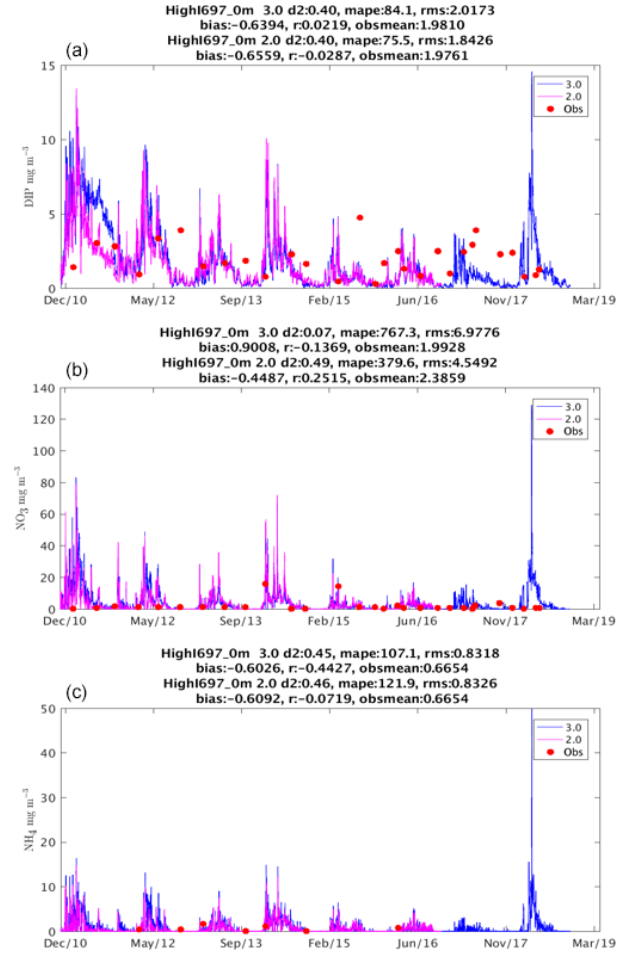
Figure 17. Dissolved inorganic phosphorus (a) , nitrate (b) and am- monium (c) concentrations at High Island, central GBR: observa- tions (red dots), simulations vB2p0 (pink) and vB3p0 (blue).